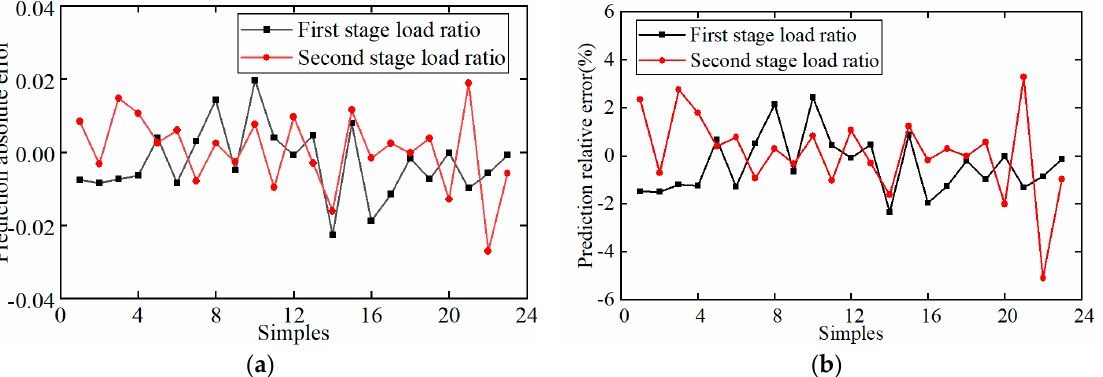
Figure 21. ( a ) Absolute prediction error of the ANN model with PSO; ( b ) relative prediction error of the ANN model with PSO.